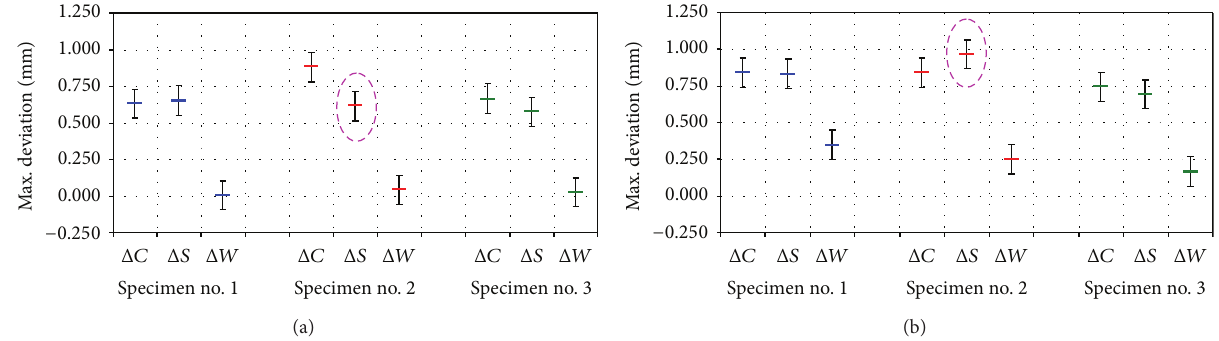
Figure 6: The deviation of measurement results of (a) traditional method and (b) proposed obtained method.